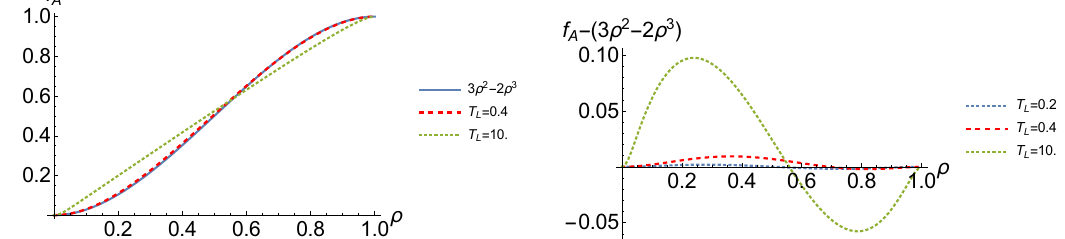
Figure 13 . Normalised entanglement entropy f A for the interval A in temperatures T L = 0 : 4 and T L = 10 : compared to the universal formula 3 (cid:26) 2 (cid:0) 2 (cid:26) 3 ( left panel ) and deviations from universal formula for T L = 0 : 2 ; 0 : 4 ; 10 : ( right panel ) The T L = 0 : 2 case was already shown on (cid:12)gure 13. In that case the deviation is approximately 0 : 002. Upon increasing the temperature of the left bath, the deviation from the universal formula grows and the time evolution resembles more a straight line | however the di(cid:11)erence f A ( t ) (cid:0) t still reaches values around 0 : 04 for T L = 10 : . See section 5.4 for a discussion of the high temperature linear behaviour. All lengths in units of AdS 3 radius ( L = 1).